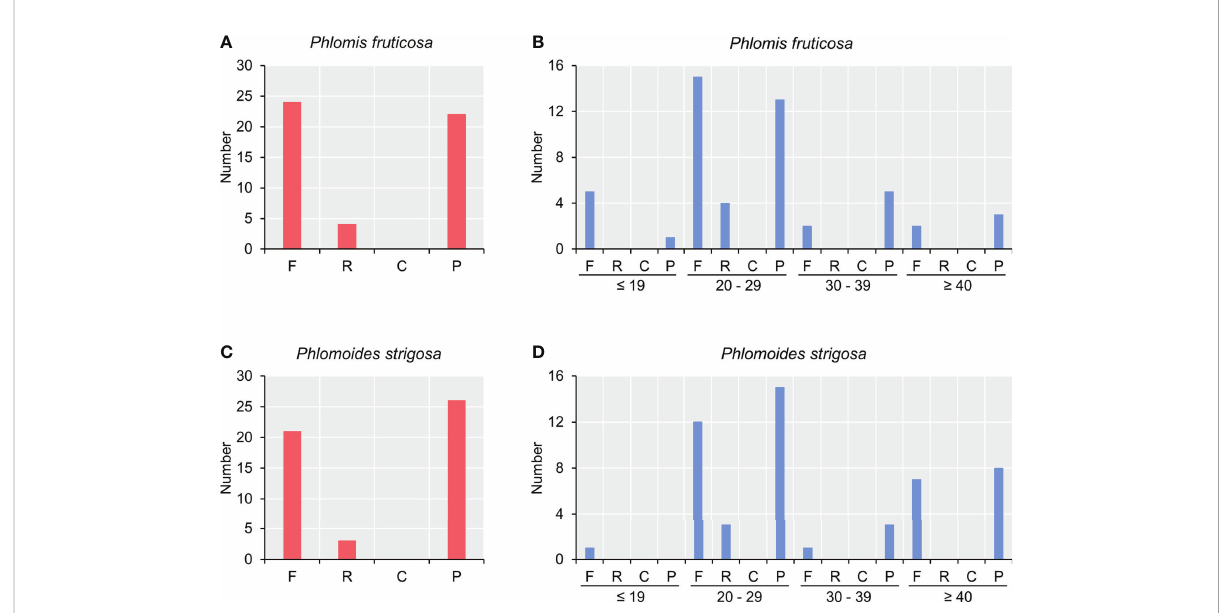
FIGURE 2 Analysis of long repeat sequence in chloroplast genomes of Phlomis fruticosa and Phlomoides strigosa . Four types of long repeat were analyzed in (A, B) Phlomis fruticosa and (C, D) Phlomoides strigosa . The x-axis represents the long repeat types, and the y-axis represents the numbers of corresponding long repeat type. F, forward repeat; R, reverse repeat; C, complement repeat; P, palindromic